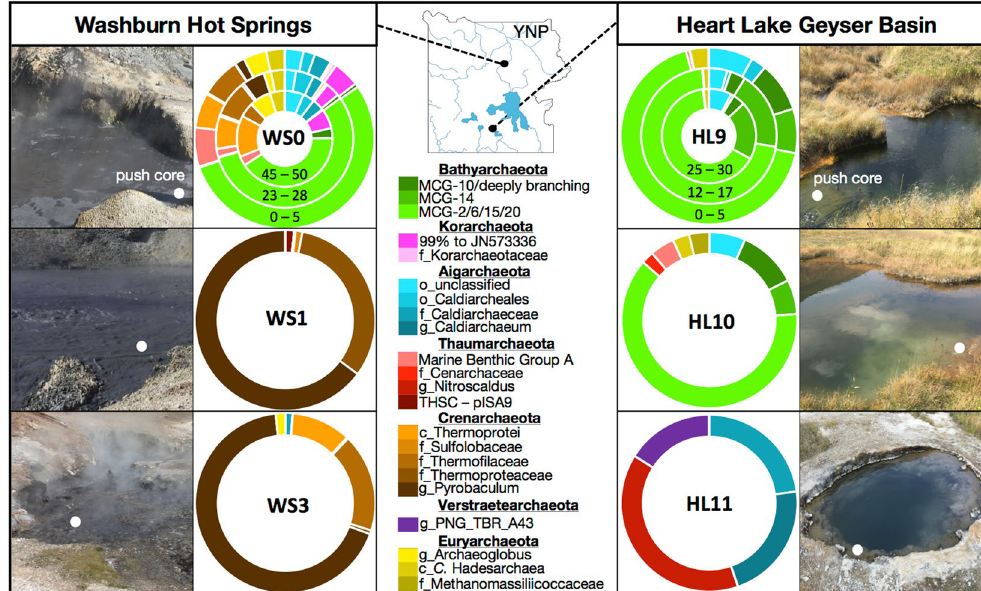
Figure 1. 16S rRNA gene diversity of Archaea in physicochemically and regionally distinct Yellowstone hot spring sediments. Taxonomic groupings of archaeal OTUs representing > 0.1% of the sequences recovered from Washburn Hot Springs (WS) and Heart Lake Geyser Basin (HL). At one spring from each region—WS0 and HL9—a sediment push core was sectioned in three layers for separate microbial analysis, and the sediment depth in cm is labeled on each respective section of the circle chart with the deepest section closest to the center. Photographs of each hot spring are adjacent to diversity charts, and white circles indicate the location of sampling. Taxonomy is grouped by phylum and the next highest resolution taxonomic group possible is listed beneath the phylum as a separate color (c = class; o = order; f = family; g = genus). For Bathyarchaeota, MCG subgroups are listed according to classifications by Kubo and Lloyd et al . (2012) and Lazar et al . (2015), except for MCG-20, which is proposed in this study (Supplementary Figure S1). The map in this figure was obtained from the public domain national park maps available from the US National Park Service (https://www.nps.gov/ hfc/carto/PDF/YELLmap2.pdf; licensing: https://www.nps.gov/hfc/carto/data-sources.cfm) and simplified with Adobe Illustrator CC 2015 (Adobe Systems;